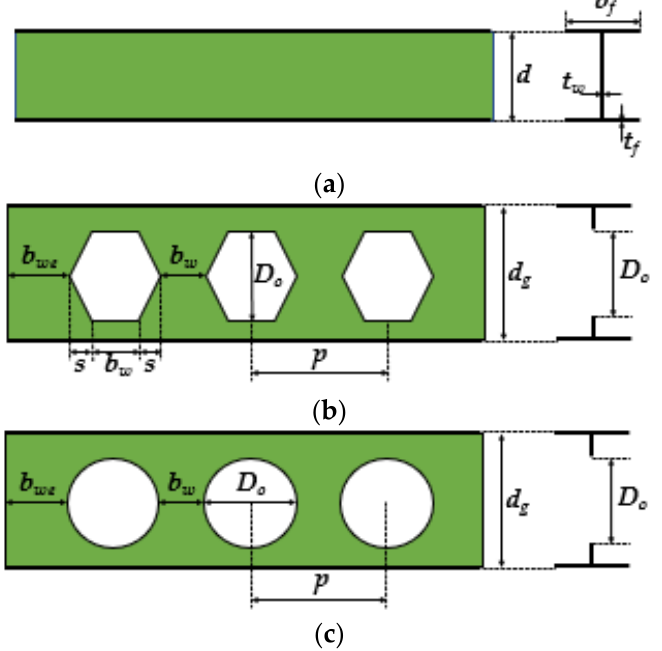
Figure 3. Geometric parameters of alveolar beams: ( a ) Parent; ( b ) Castellated; ( c ) Cellular section. b f = flange width; b w = web-post width; b we = end-post width; D 0 = opening depth or diameter; d = parent section depth; d g = alveolar beam depth; p = length between the opening diameter centers; s = length of the hexagonal opening diagonal edge; t f = flange thickness; t w = web